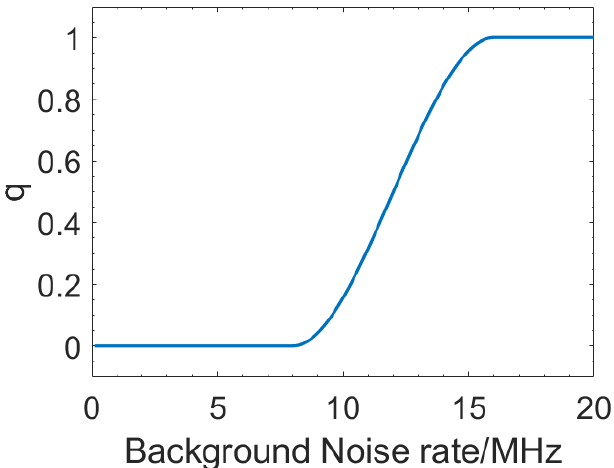
Figure 10. Smooth step function related to the background photon count rate .